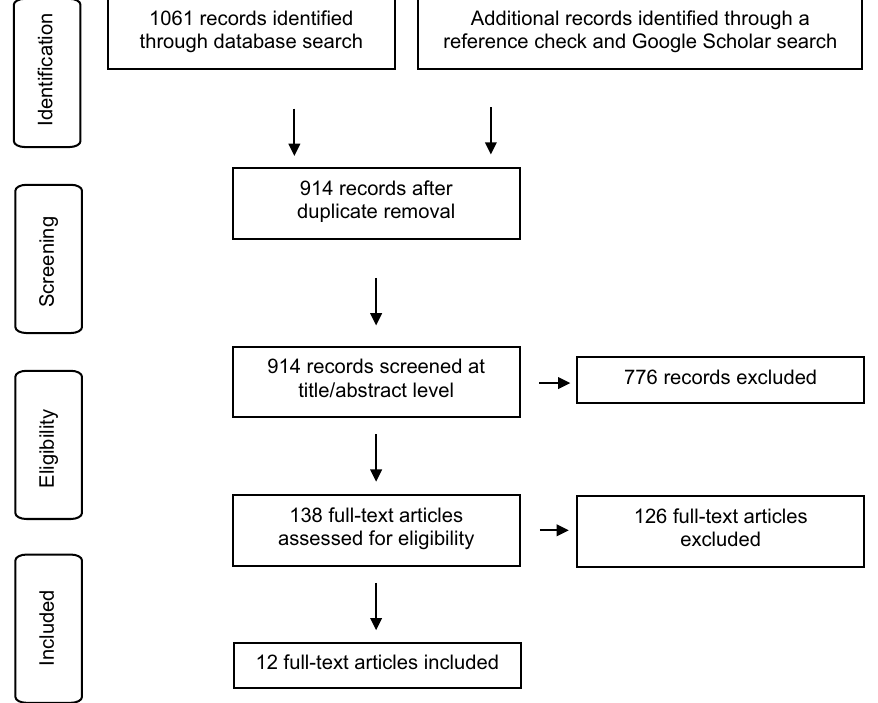
Fig. 2 PRISMA flow chart